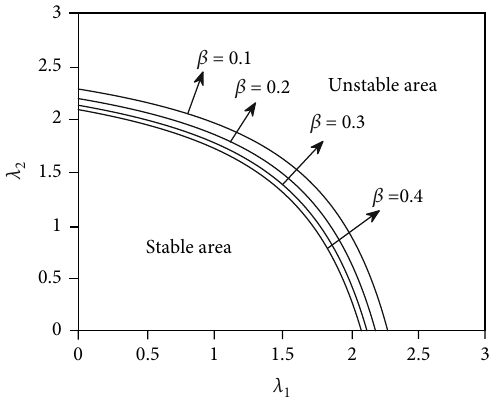
, λ Þ with di ff erent values of β . 1 2